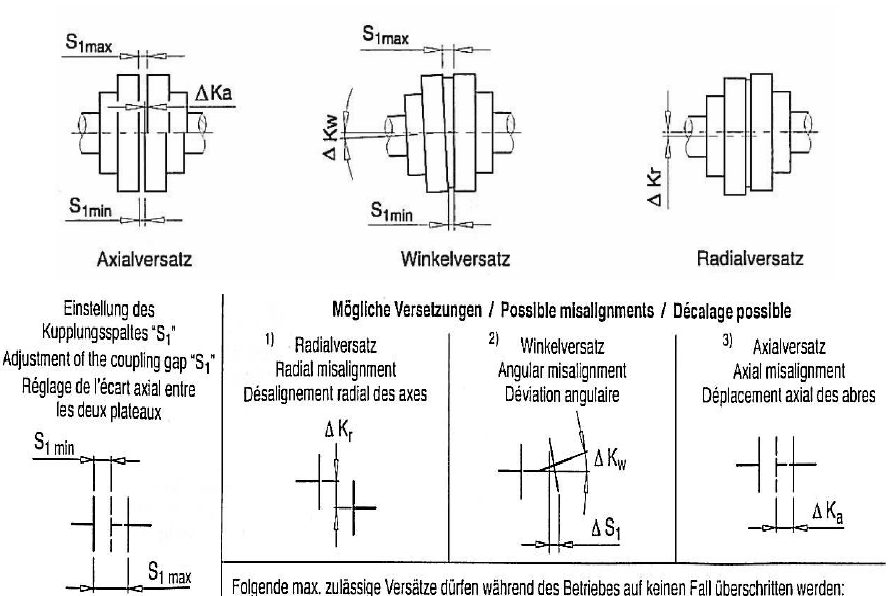
Figure 17 – Display and calculations of discrepancies of elastic couplings in the 3-D system Рисунок 17 – Изображение и расчет расхождений эластичных муфт в системе 3-D Слика 17 – Приказ и прорачун одступања еластичних спојница у 3-D систему For A480 N-EUPEX elastic coupling the values S S =10 mm are prescribed. The permitted values of axial deviations 1max , radial deviations  Kr , angular deviations  Kw  K azul zul difference between the maximum and minimum clearance  S S are prescribed. The values of clearances of these gaps are: 1min =  S =  K =1.1 mm,  Kw =0.11  and for RUPEX coupling  Kr zul 1zul azul zul